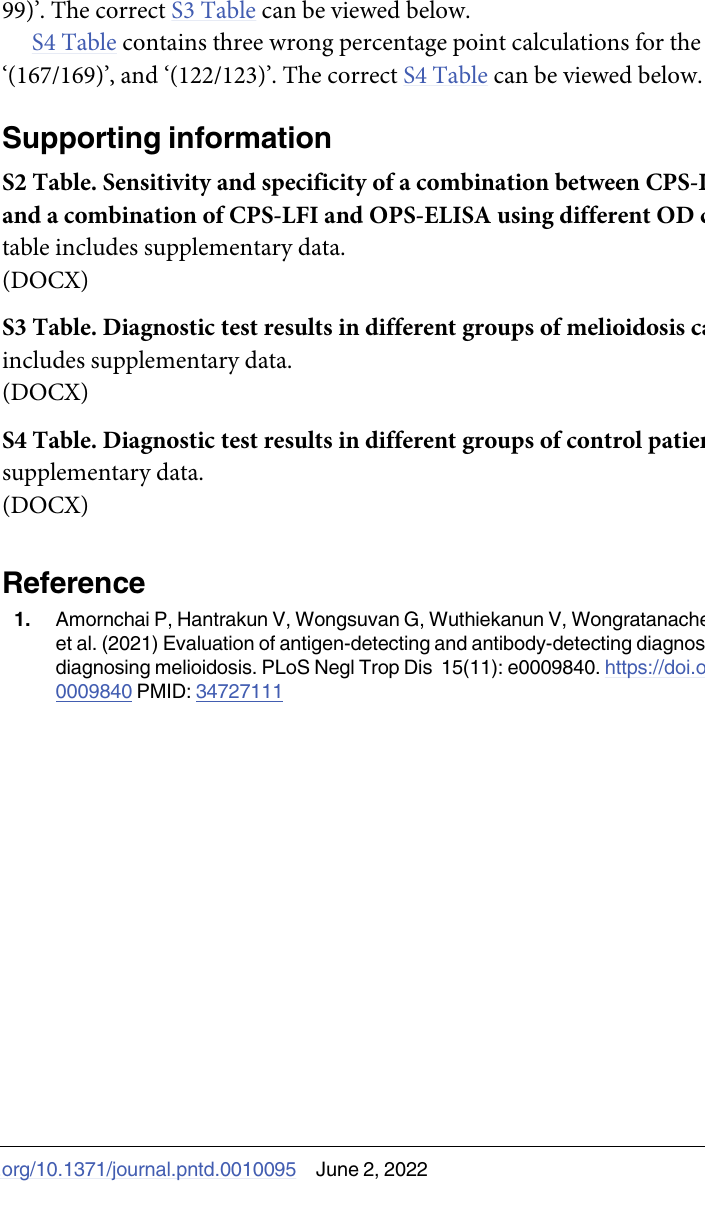
S4 Table contains three wrong percentage point calculations for the values ‘(162/169)’, ‘(167/169)’, and ‘(122/123)’. The correct S4 Table can be viewed below.